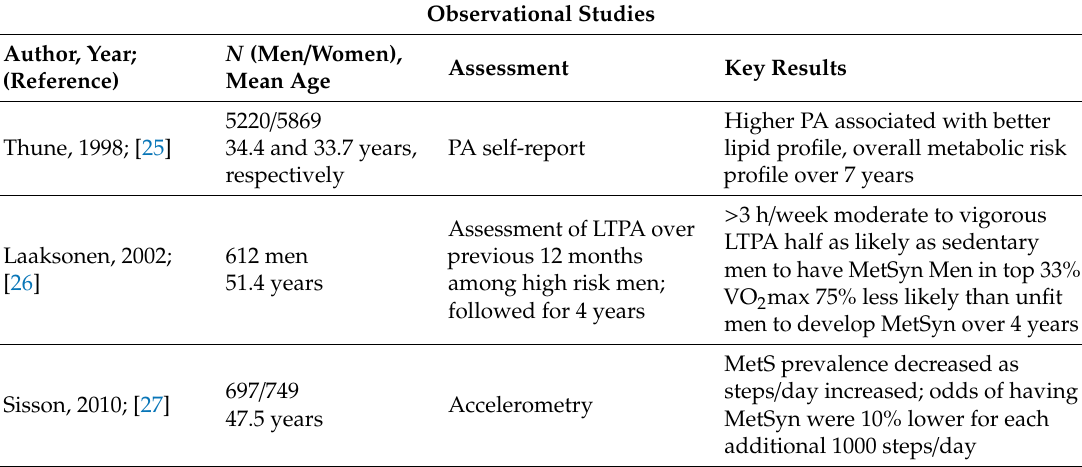
Table 1. Sampling of studies assessing the impact of physical activity patterns or exercise intervention on the metabolic